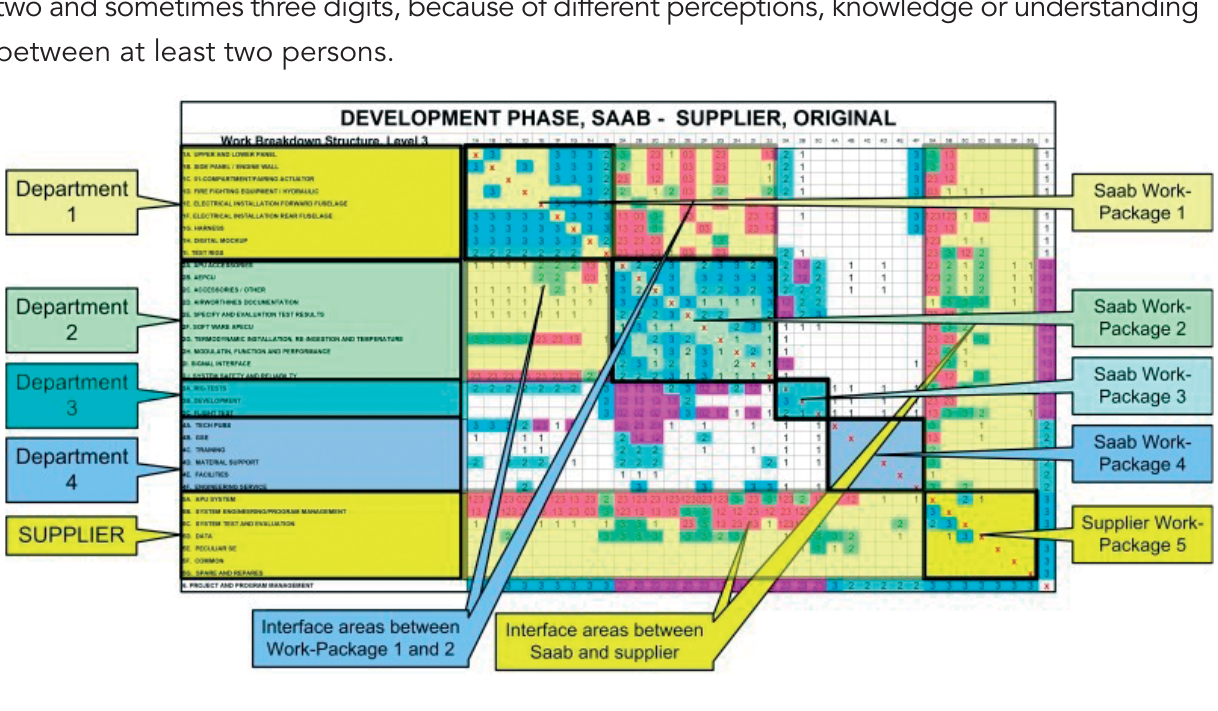
Figure 5: DSM-Analysis on WBS-Level 3 “as